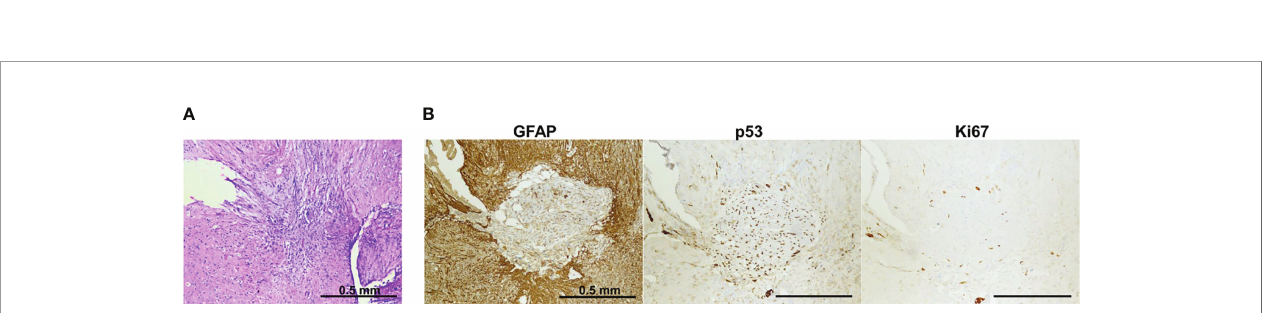
FIGURE 6 | IHC characterization of GBM7-Luc2-mKate2 xenograft. Representative H&E (A) and IHC (B) stained sections of a whole tumor. Bars are applicable to all images in the row.